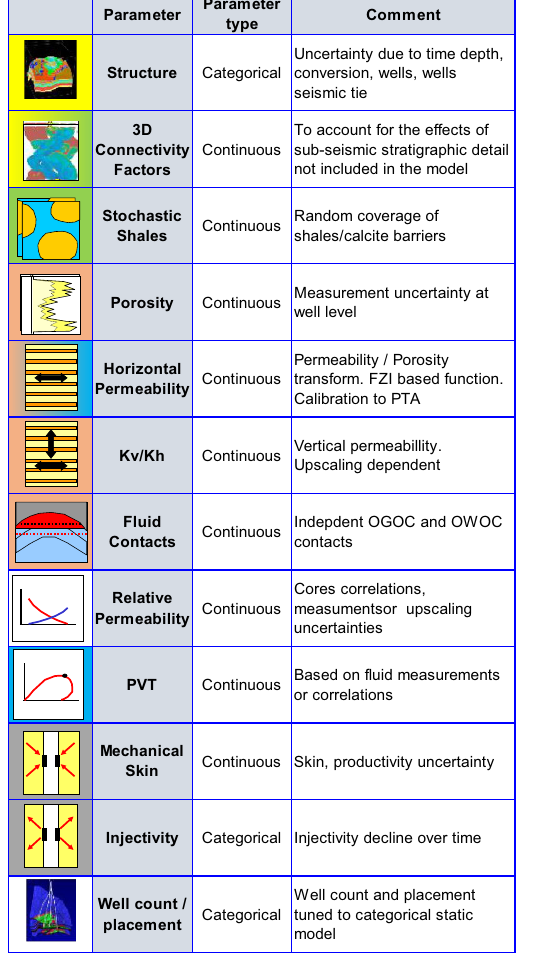
Table 1 XX‑XY reservoir uncertainty matrix Parameter Parameter type